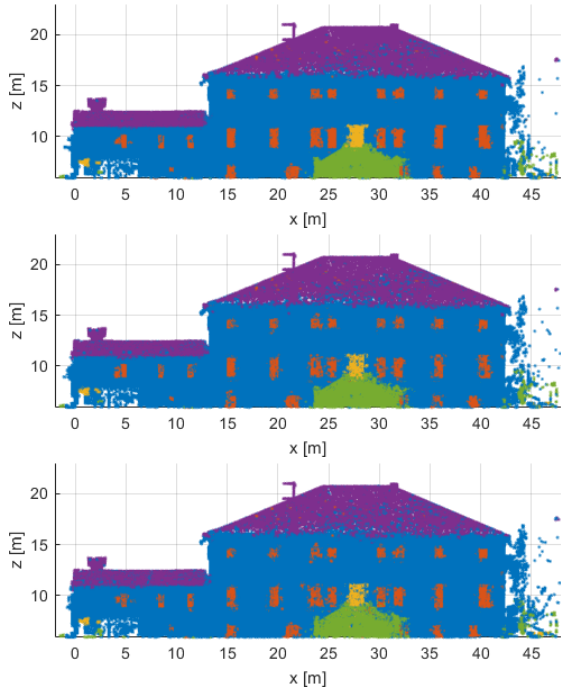
Figure 9. Predicted semantic segmentation of Villa Roberti Bru- gine: best view approach (case A)) increasing (from the top to the bottom row) the noise level in the synthetic labeled